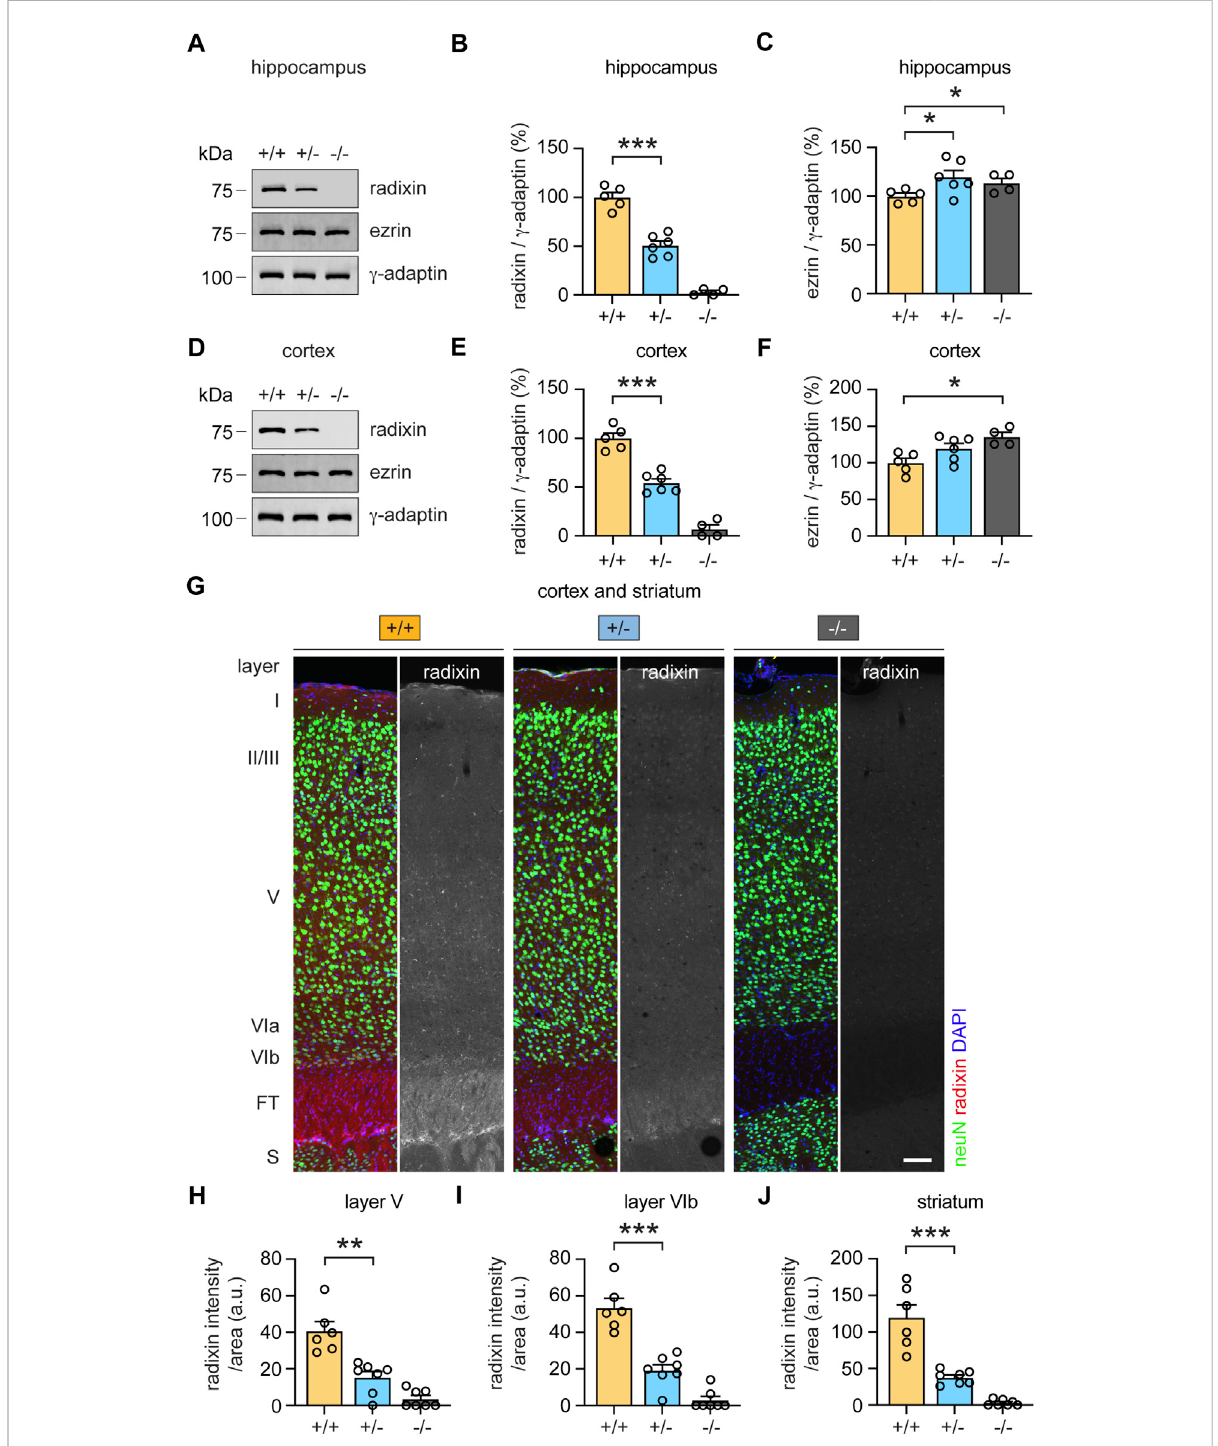
Monoallelic loss of rdx reduces radixin protein expression in the cortex, hippocampus and striatum. (A) Representative western blot analysis of radixin (Rdx) and ezrin (Ezr) in hippocampal extracts derived from adult (+/+), (+/-) and ( − / − ) rdx knockout mice. γ -adaptin was used as loading control. Kilodalton (kDa). (B,C) Quanti fi cation of Rdx (B) and Ezr (C) signal intensities normalized to γ -adaptin as shown in (A) . (+/+) set to 100%. N = 4-6 mice per genotype. (D) Representative western blot analysis of Rdx and Ezr in cortical extracts derived from adult (+/+), (+/-) and ( − / − ) rdx knockout mice. γ -adaptin was used as loading control. Kilodalton (kDa). (E,F) Quanti fi cation of Rdx (E) and Ezr (F) signal intensities normalized to γ - adaptin as shown in (D) . (+/+) set to 100%. N = 4-6 mice per genotype. (G) Immunohistochemical analysis of Rdx (red or gray) protein